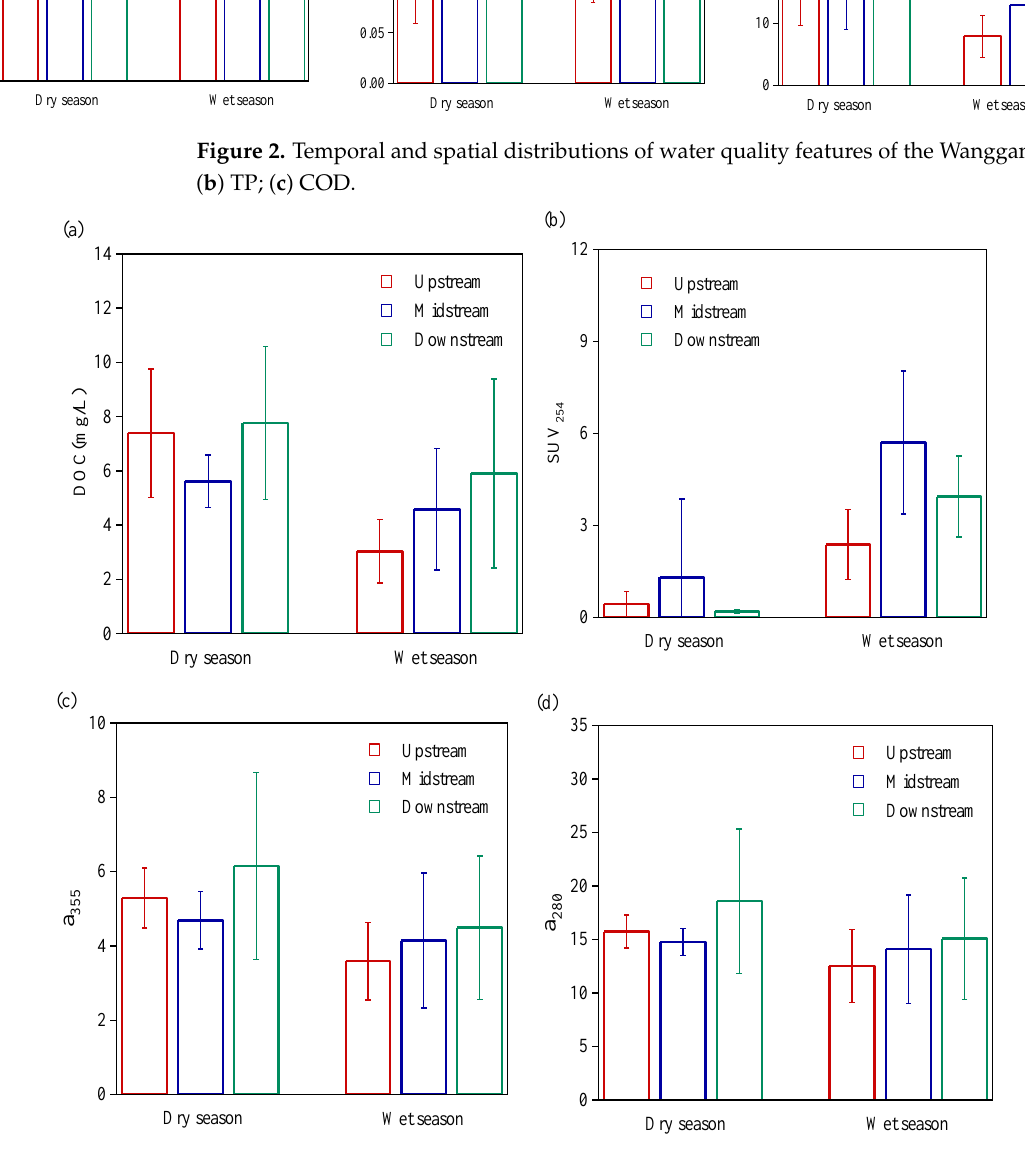
Figure 3. Distributions of DOC and UV – Vis spectral parameters in the Wanggang River. ( a ) DOC; ( b ) SUV 254 ; ( c ) a 355 ; ( d ) a 280 .